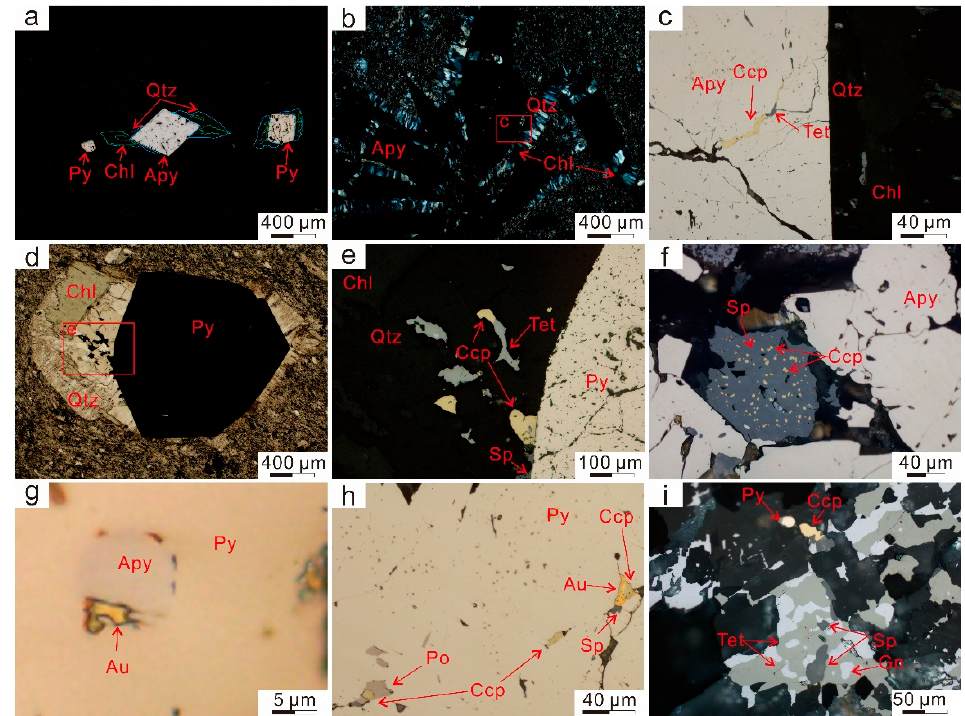
Figure 4. Paragenetic assemblages and sequences of minerals at the Zhengchong gold deposit.